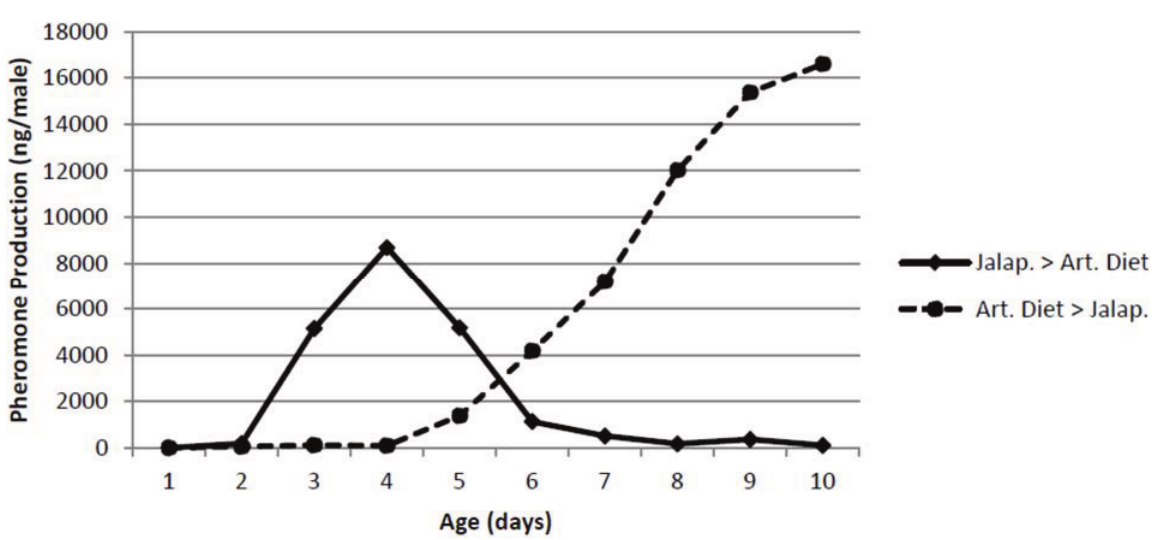
Figure 5. Effect of switching diet on pheromone production. The two treatments were jalapeno followed by artificial diet (Jalap. > Art. Diet) and artificial diet followed by jalapeno (Art. Diet >